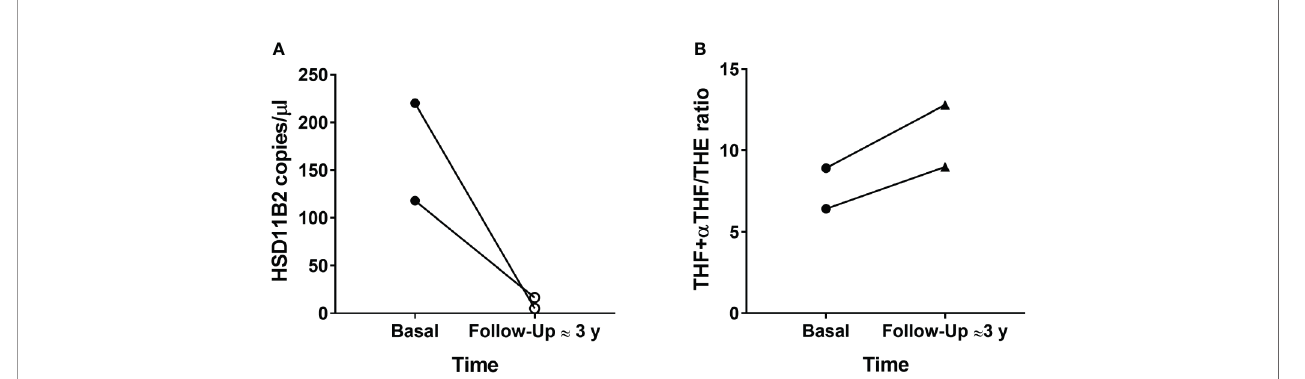
FIGURE 4 | HSD11B2 exosomal mRNA (copies/µl) (A) and THF+allo-THF/THE ratio (B) in the two probands 221 GG mutated at enrolment and follow-up ( ≈ 3